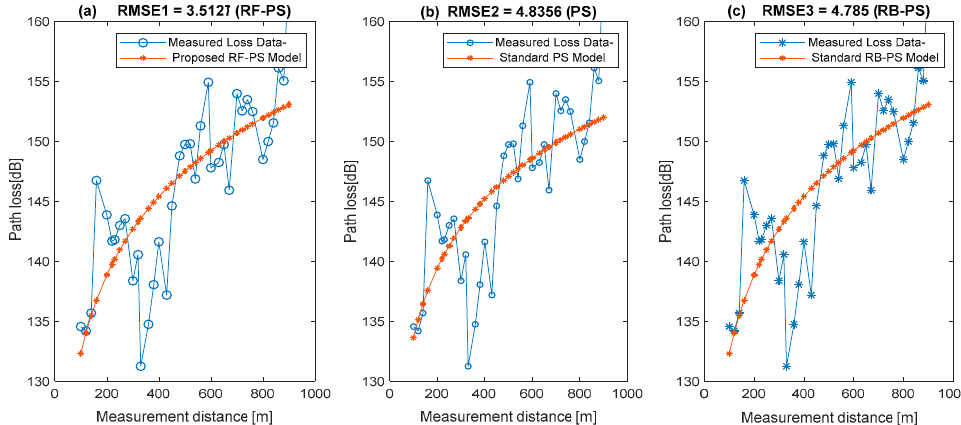
Figure 8. Results showing the measured path loss versus distance using the hybrid RF-PS method and two existing standard path loss prediction methods in site 1 of location 1.